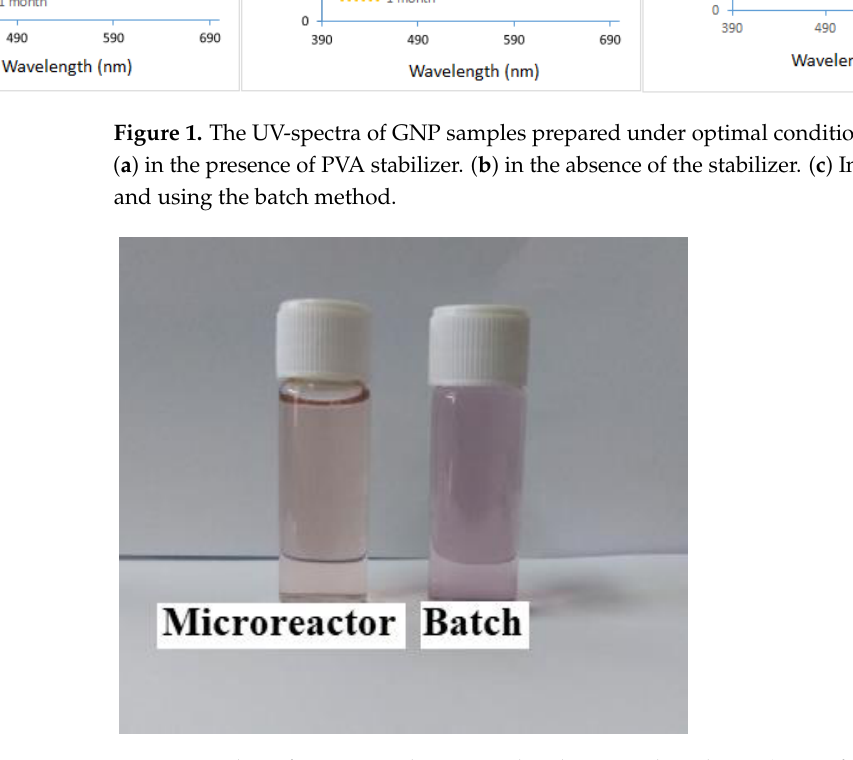
Figure 2 . Colors of GNPs samples prepared under optimal conditions (Cons of SC, SB, HAuCl 4 = 0.1 mM, initial pH = 3, and T = 308.15 K).